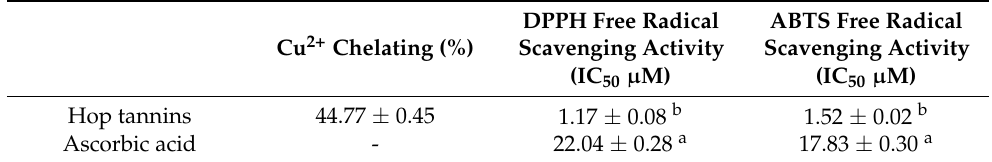
Table 2. Copper ion chelating and antioxidant abilities of hop tannins 1